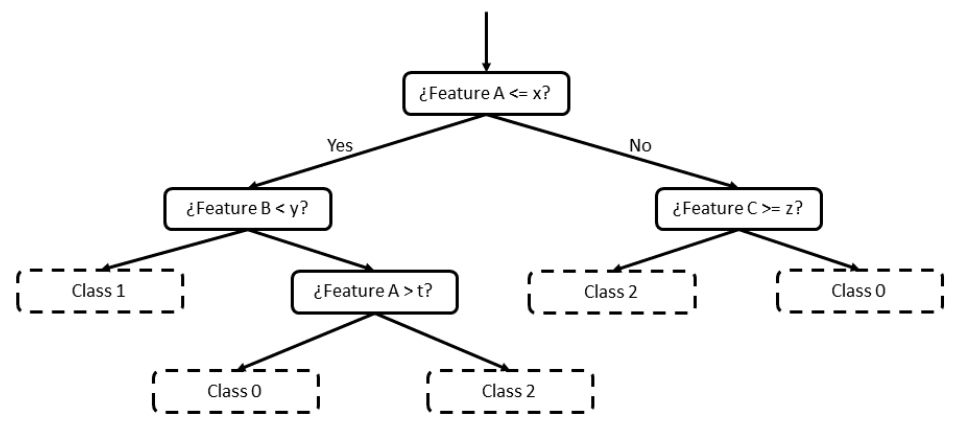
Figure 3. Decision tree